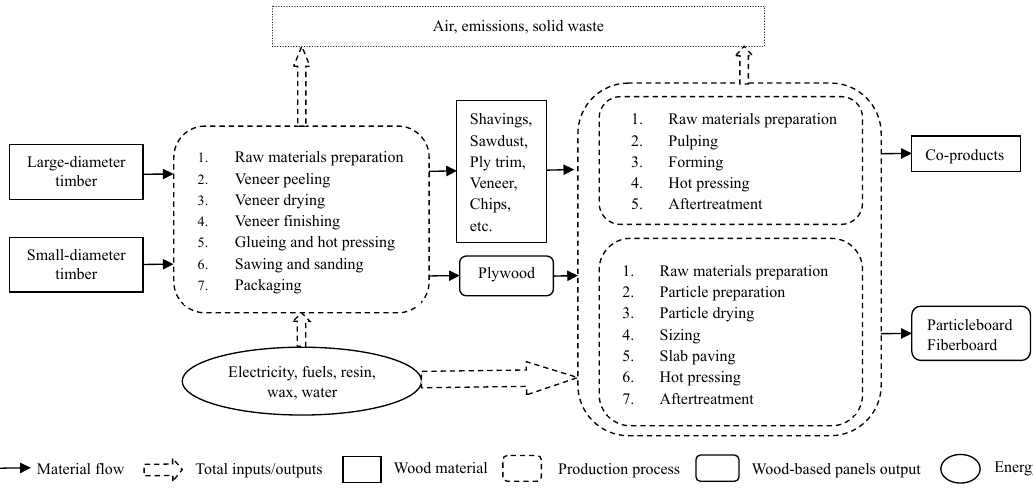
Large-diameter timber